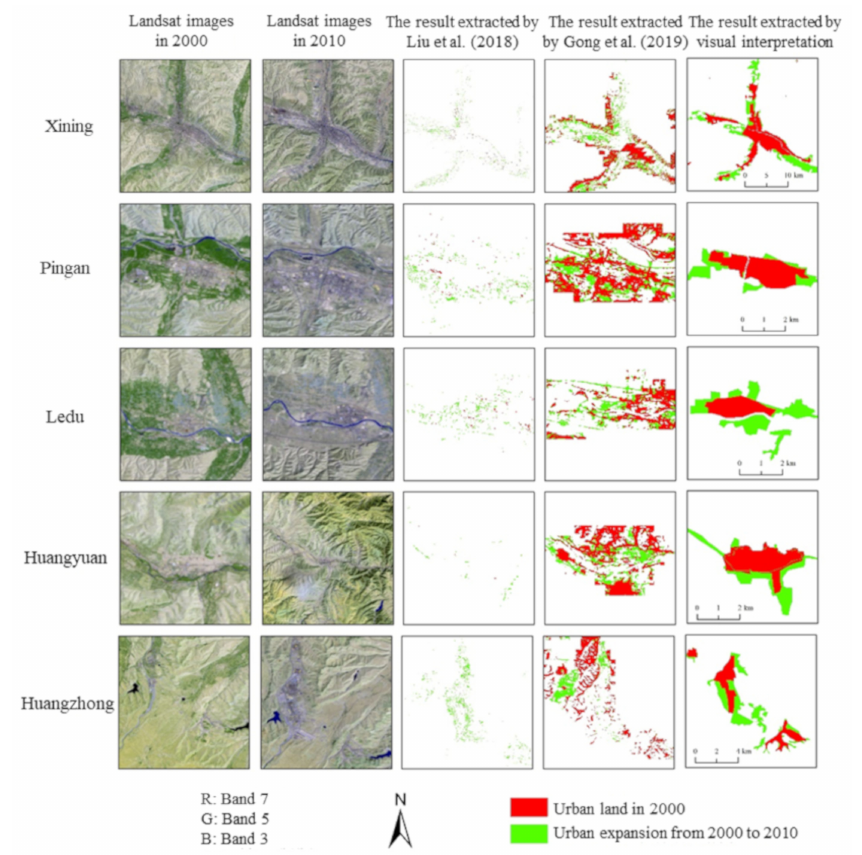
Figure 10. The comparison between urban land data obtained by visual interpretation and existing data from 2000 to